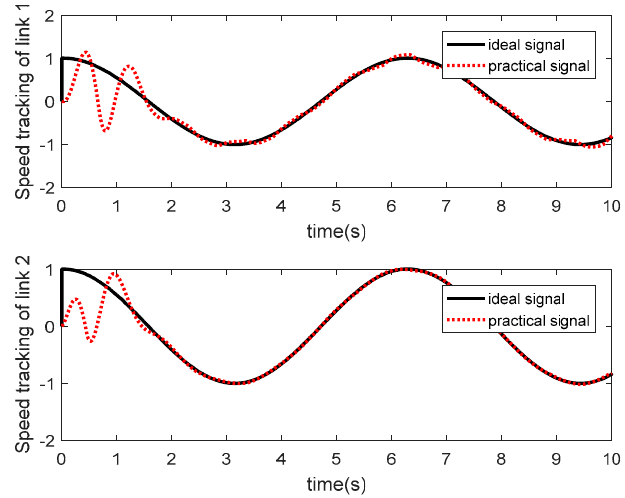
Figure 10. Angle tracking of joints 1 and 2.